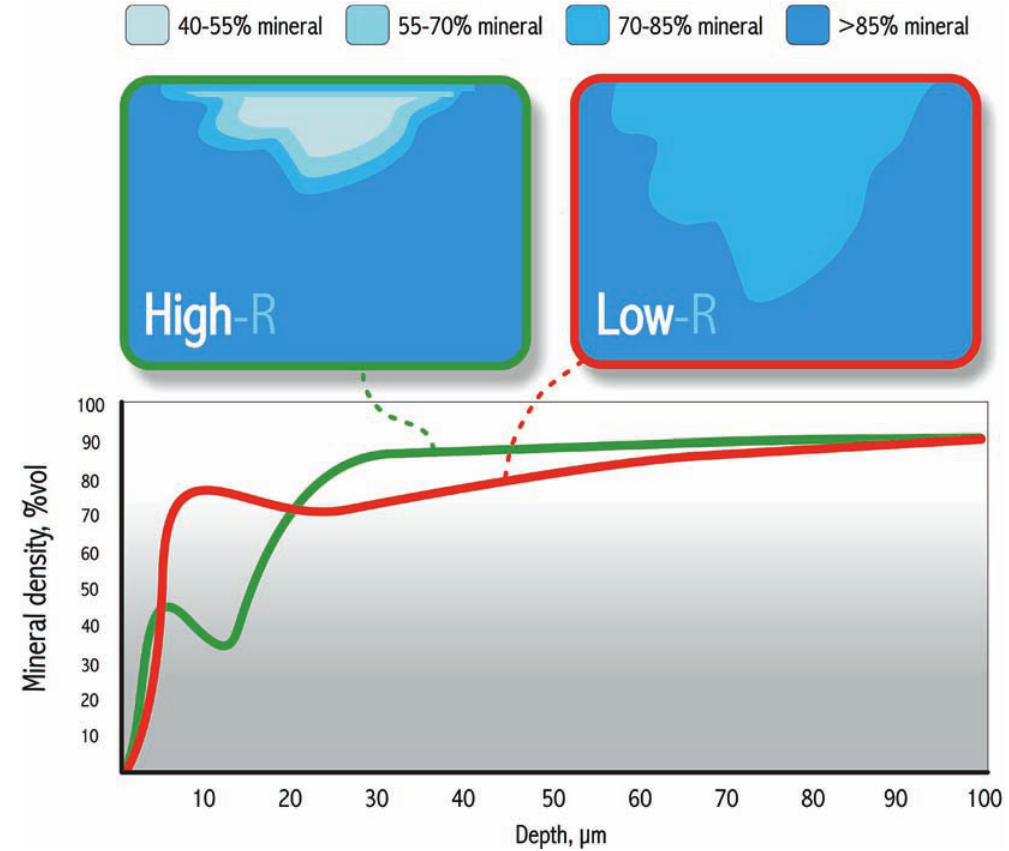
Figure 8- Mineral distribution in low-R and high-R caries lesions. High-R lesions give better discrimination among the treatments under study and seem to be more appropriate to compare the efficiency of remineralizing systems, such as fluoridated dentifrices. Low-R lesions are more appropriate when physiological mineral distribution is required.